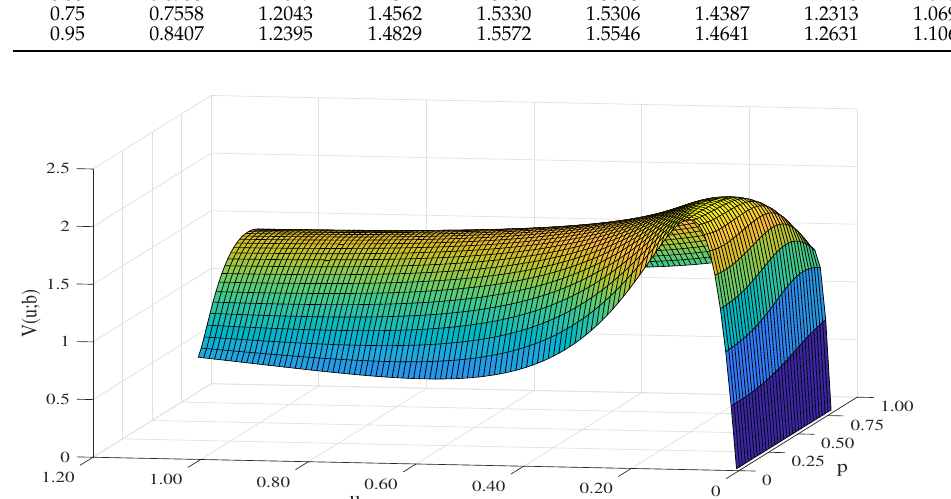
Figure 3. Images of V ( u ;0.5 ) when N = 10, ˆ α = 1